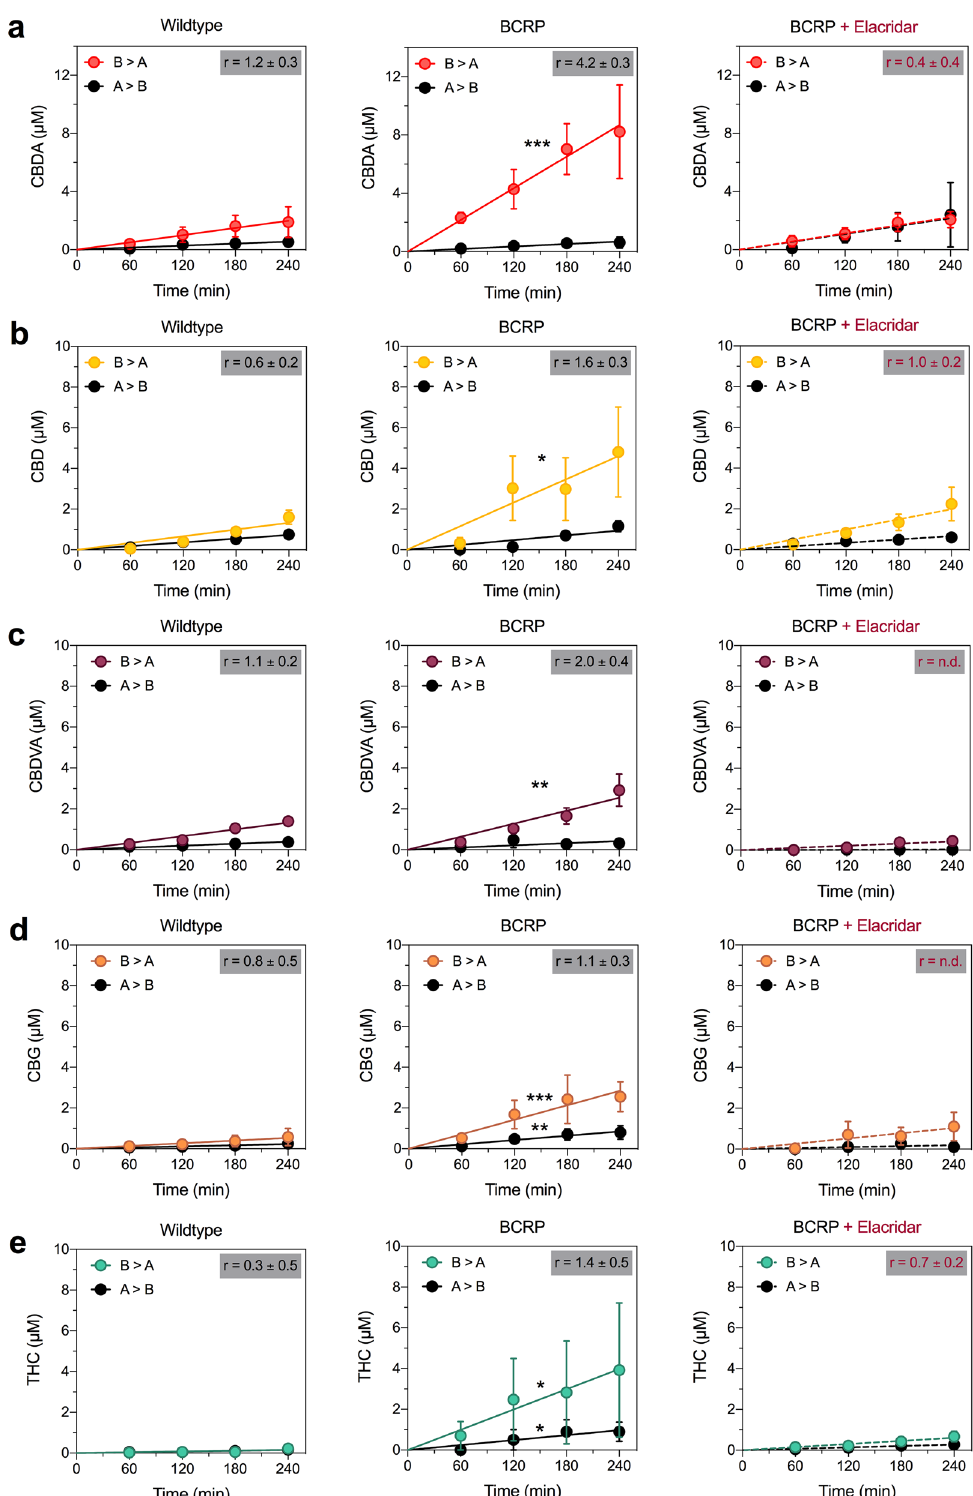
Figure 2. CBD, CBDA, CBDVA, CBG and Δ 9 -THC are substrates of BCRP. Concentration–time curves for ( a ) CBDA, ( b ) CBD, ( c ) CBDVA, ( d ) CBG and ( e ) Δ 9 -THC in wildtype (left panel) and BCRP-expressing (middle panel) MDCK cells in the basolateral to apical (B > A) and apical to basolateral (A > B) directions. Right panels represent concentration–time curves for cannabinoids in cells expressing BCRP in the presence of the inhibitor elacridar (dashed lines). Data are expressed as means ± SEM, with n = 4 per time point. Curves represent fits to a linear regression and transport efflux ratios (r) are listed (* p < 0.05, ** p < 0.005, *** p < 0.0005 compared to wildtype; Extra sum-of-squares F